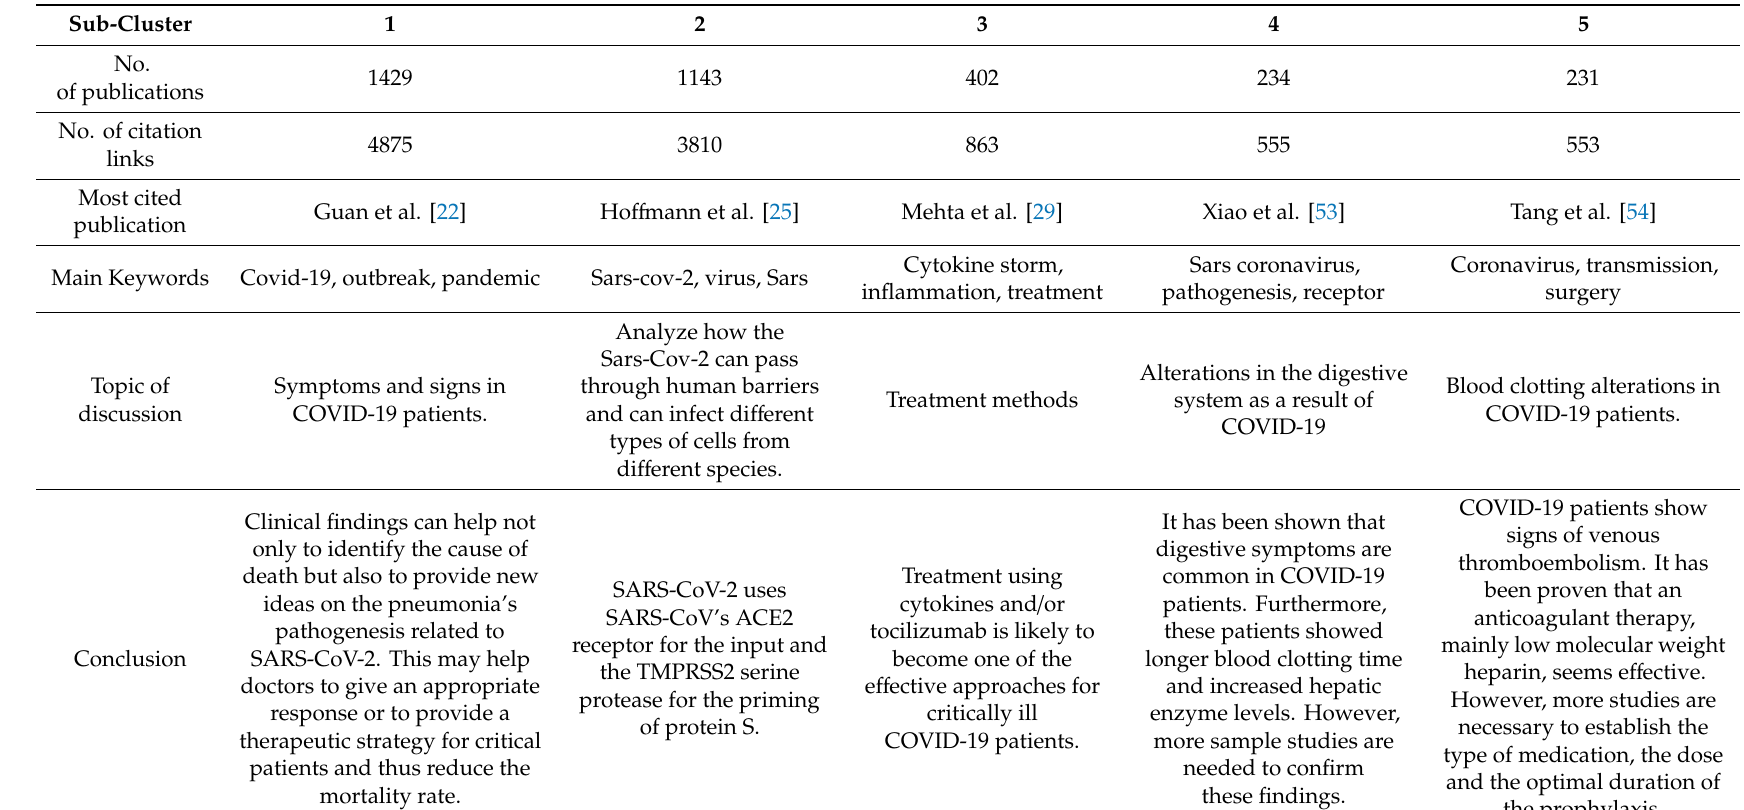
Table 5. Main citation network groups from the sub-cluster of Group